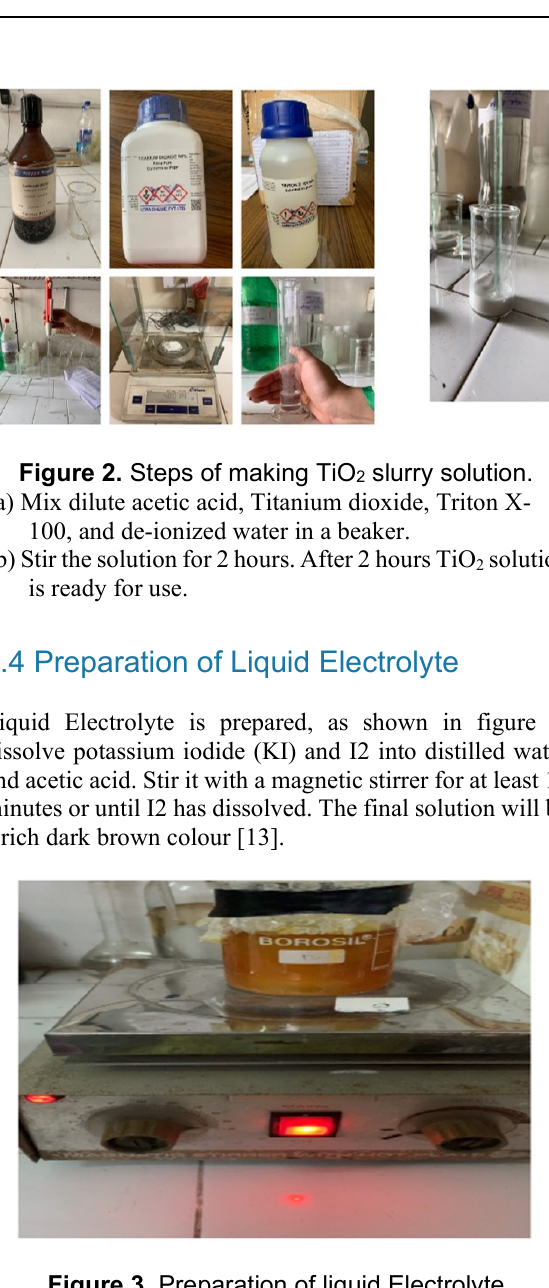
Figure 3. Preparation of liquid Electrolyte